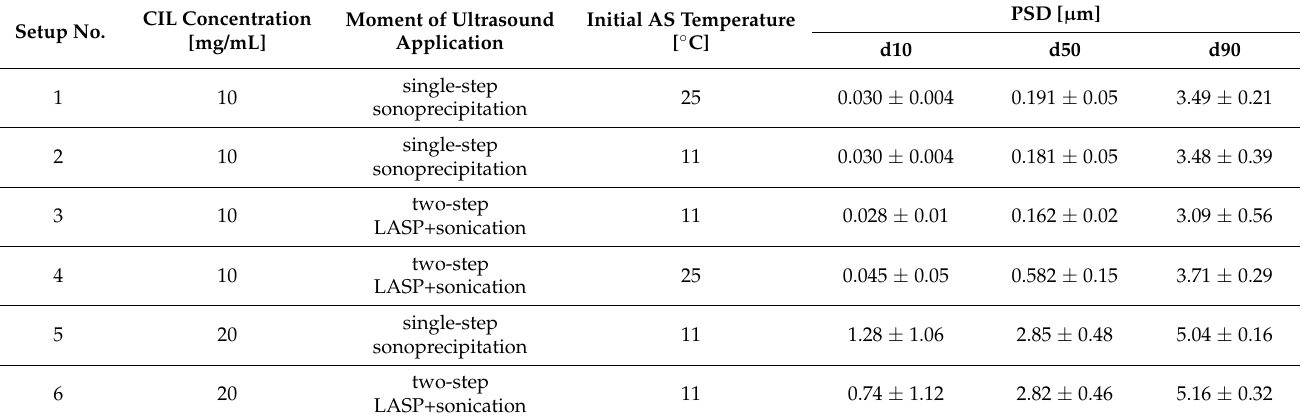
Table 4. Settings and results (mean ± SD) of the optimization study for sonoprecipitation (n = 3). Setup